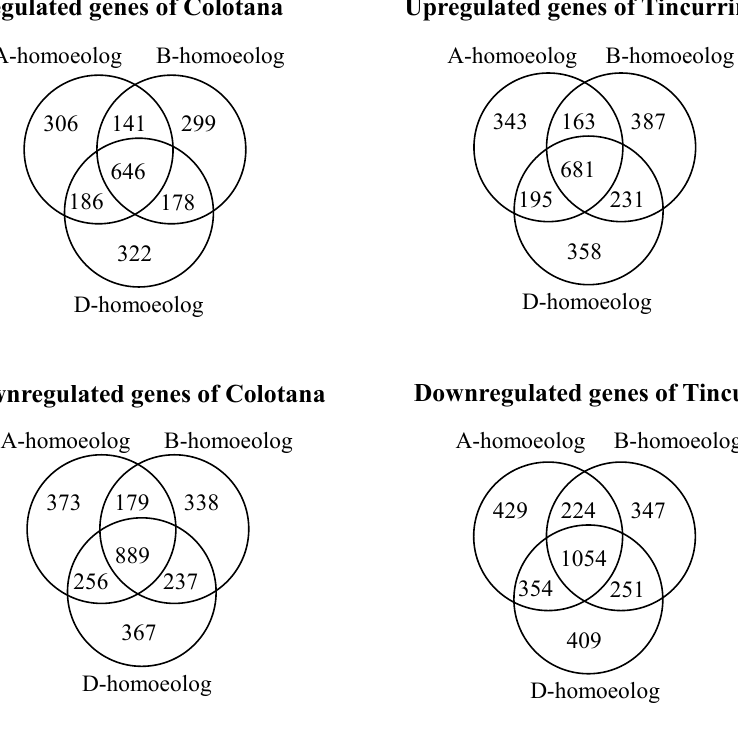
Figure 3. Classification of the di ff erentially expressed genes in the A, B, and D subgenome after water stress in Colotana and Tincurrin genotypes. Venn diagram analysis showed relationship of the up- and downregulated homoeologous genes between the two